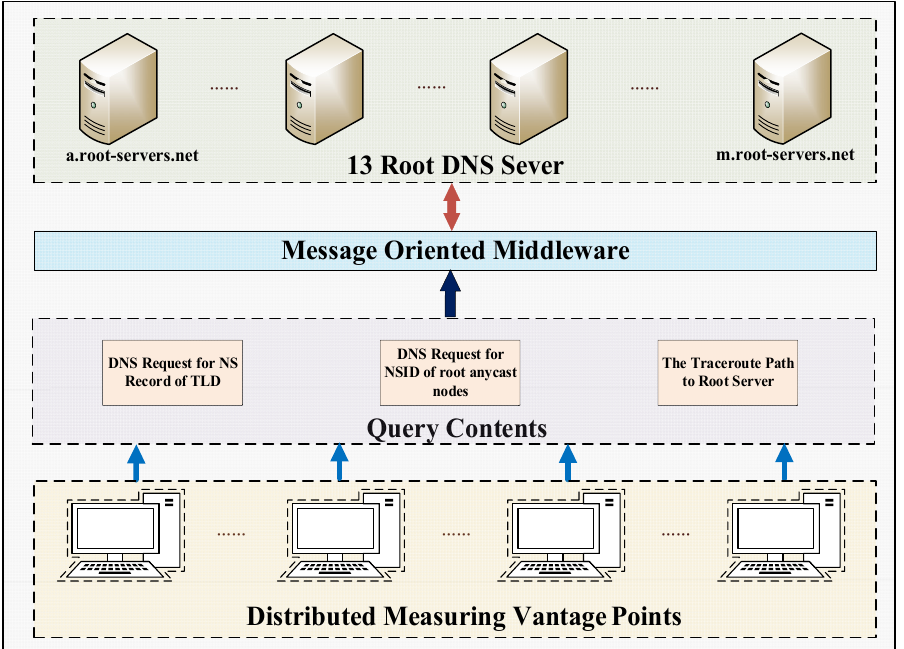
Figure 3. Schematic diagram of the active measurement structure.